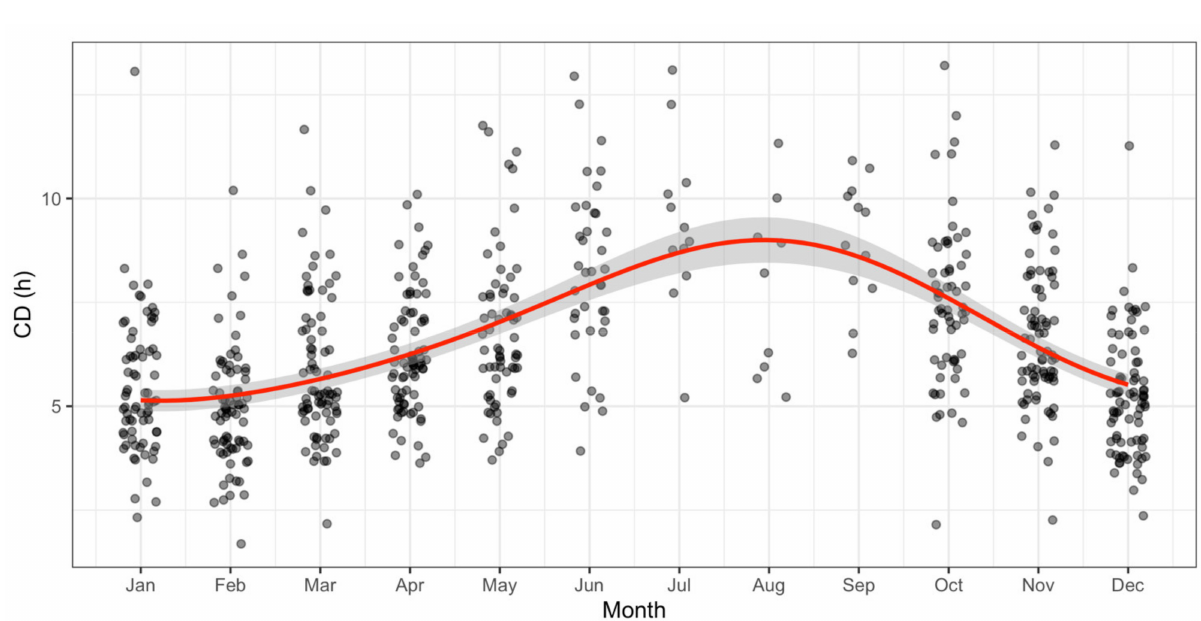
Figure 3. Red represents the monthly sinusoidal model of CD (Equation (11)). The grey area corresponds to the standard error of the model using linear regression. The grey dots represent the monthly CD values per station, as computed from Algorithm